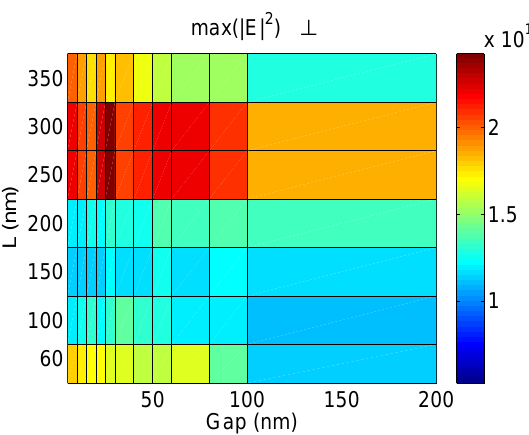
Figure 8: Linear behavior of the relative gap reduction as a function of the field enhancement.